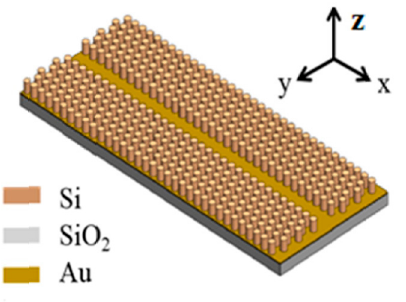
Figure 3. Hybrid waveguide composed of Si pillars (shorter than those in Figure 1a) on SiO 2 substrate and embedded in a thin layer of